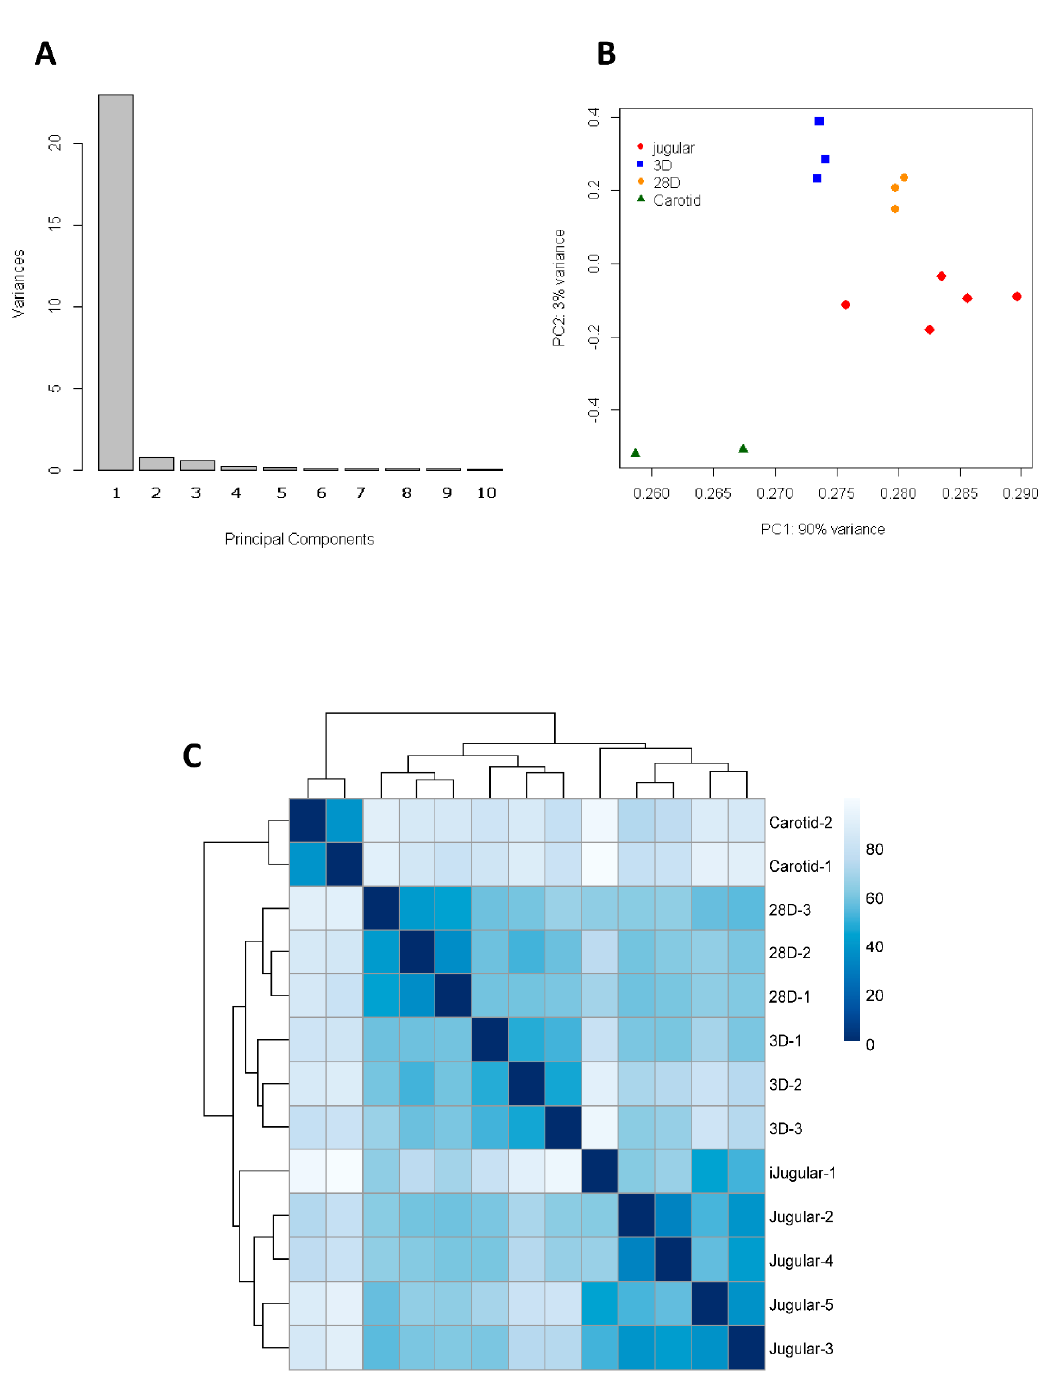
Figure 1. Analysis of 9846 detected genes. ( A ) Plot of eigenvalues of the principal components. Most of the variance in the dataset is contained in the first two principal components (PCs). ( B ) Visualization of the dataset in the subspace of the first two PCs. Jugular vein samples are represented in red, 3D in blue, 28D in orange, and carotid in green. ( C ) Heatmap of sample-to-sample Manhattan distances using the dataset of 9846 genes expressed in all samples of the study. The distances of the experimental source are visualized according to light or dark blue color (low or high correlation, respectively).